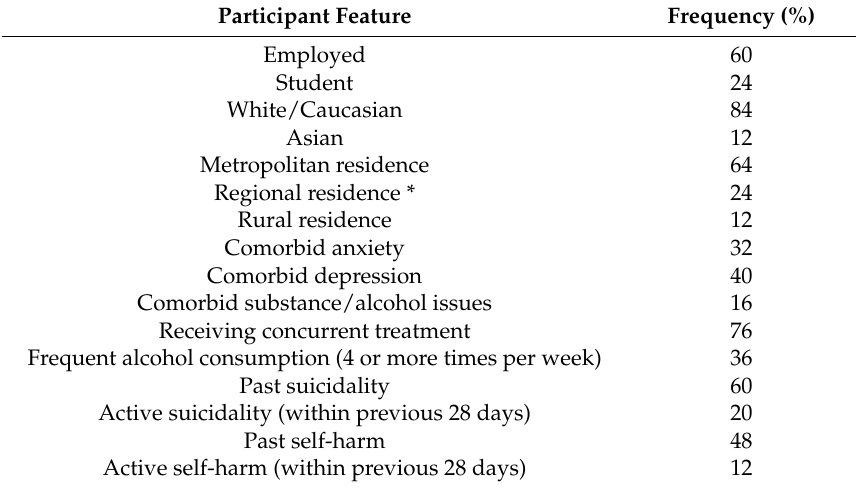
Table 1. Baseline characteristics of participants ( n =